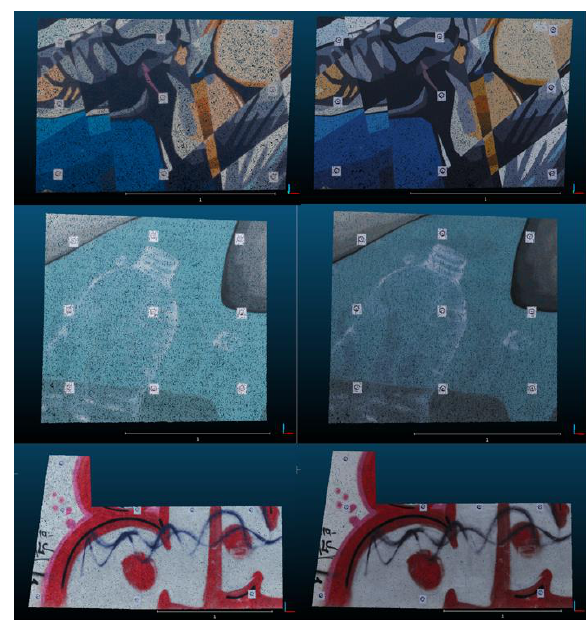
Figure 5: Bayer & FOVEON RGB Point Clouds After the point clouds were generated, they were compared against the reference laser scanner point cloud in CloudCompare. axis (Y axis) are computed from the reference and then from each